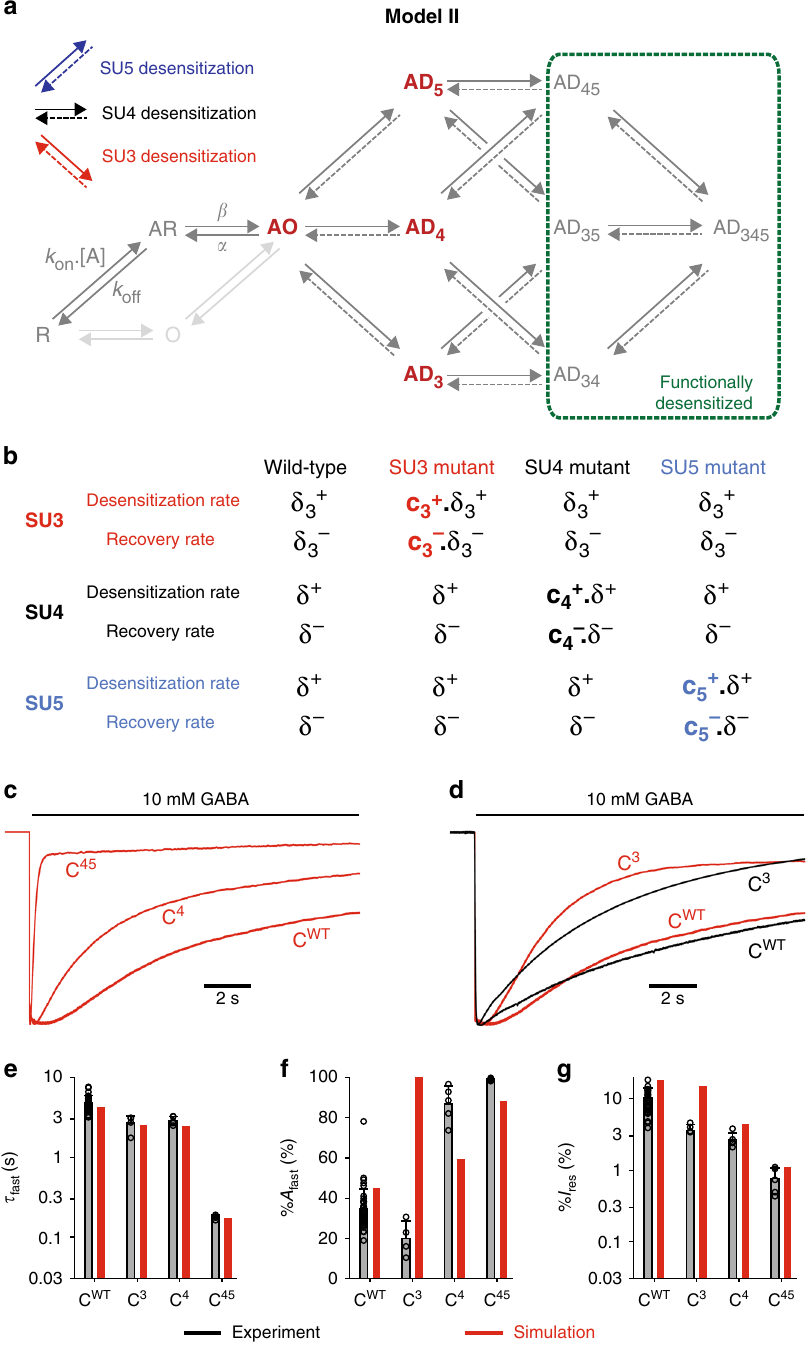
Fig. 5 Model II: Two desensitized subunits are required to occlude the pore. a Model II builds upon Model I by adding one key hypothesis: receptors with only one subunit in its desensitized conformation are still conducting, and desensitization occurs when at least two subunits are desensitized. Thus, states AD 3 , AD 4, and AD 5 are open states from a functional point of view. b In Model II, mutation of a subunit can affect both its desensitization and recovery, as shown here with an example in which both SU4 and SU5 are mutated (construct C 45 ): c 4 + and c 5 + re fl ect the increase in desensitization rates, c 4 − and c 5 − re fl ecting the increase in recovery rates. c Simulated currents for C WT , C 4 and C 45 . d Representative currents for C WT and C 3 in black, are compared to their simulation counterparts in red. e – g Bar graphs summarizing the experimental data (in black) vs the simulations (in red) for the indicated concatemers on the kinetics (panel e ) and the amplitude (panel f ) of the fast desensitization component as well as the residual current after a 1 min long application of 10 mM GABA (panel g ). Experimental data are shown as means (bar graphs) and standard deviations (error bars), with individual data points indicated as circles. Note that the results for the C 5 construct are not displayed, since the experimental data are almost identical to that of C 4 (see Fig. 2) and since the simulations for C 4 and C 5 are identical (see Supplementary Table 3). See Supplementary Fig. 5 for all simulation results; Supplementary Table 1 for numerical experimental values, the number of cells and number of independent series of experiments; and Supplementary Table 3 for the numerical values of